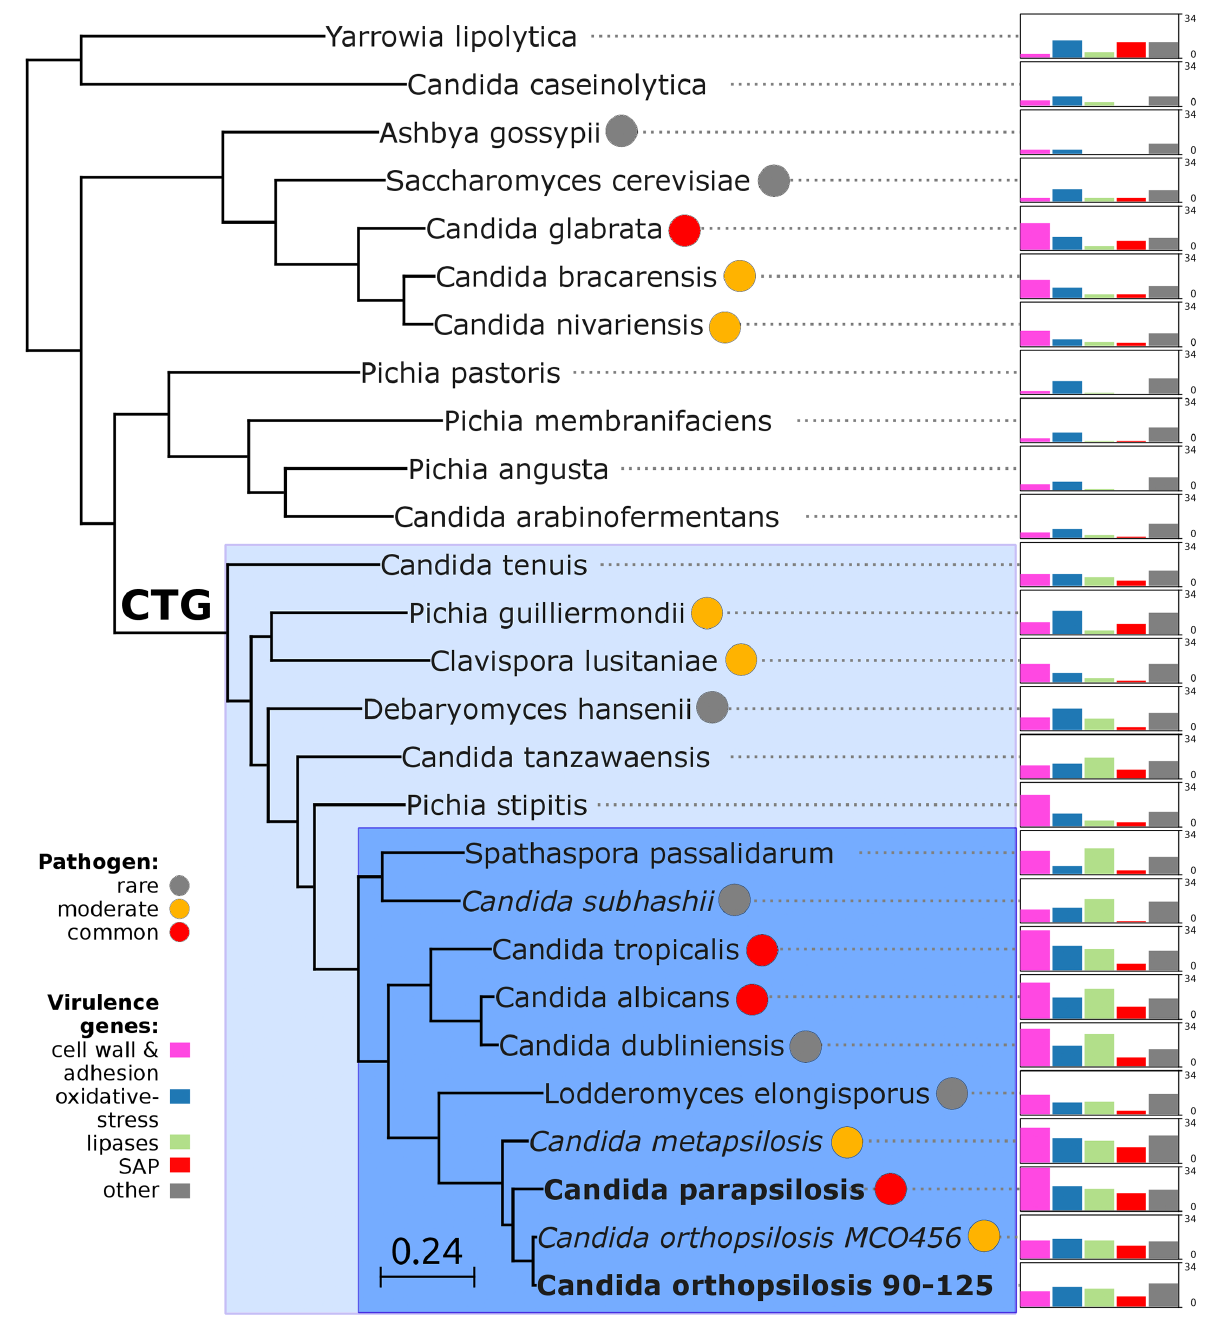
Fig 5. Phylogeny and genome composition in Candida and related species. Species translating CUG codon as serine (CTG clade) are denoted with color background: haploid species in light blue and diploid species in dark blue. Common human pathogens (red), moderate pathogens (orange), and rare pathogens (grey) are marked with color circles. Species with heterozygous genome are in italic , while extremely homozygous genomes are in bold. Barcharts with number of virulence-related genes for: i) cell wall (HYR/IFF) and adhesion (ALS/EPA) (pink), ii) oxidative-stress response (SOD, CAT, GPX, YBH) (blue), iii) lipases (LIP, PLB, SRR, FOX) (green), iv) secreted aspartic proteinases (SAP) (red) and v) other virulence-related genes (grey) including drug resistance genes (TPS, ERG), regulators (STE20, WH11, PHO100), iron acquisition (FTR1). Barcharts are scaled from 0 to 34 for all